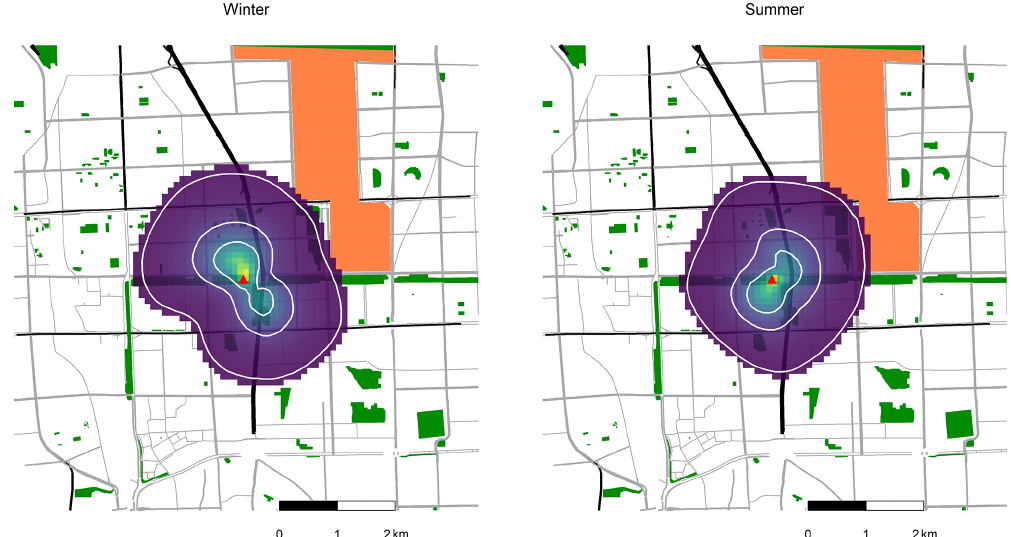
Figure 3. The mean flux footprints for the winter and summer campaigns. The site is shown by the red triangle in the centre of the map. Each square is 100m 2 and the brighter colours indicate a greater influence on measured emission for a particular area. The white rings show the areas contributing 30%, 60% and 90% to the flux total, with the inner ring representing the 30% contribution and the outer ring representing the 90% contribution. The 90% of the influence from the footprint extends up to 2km away from the tower with maximum contribution 0.26km away from the tower. Map was built using data from © OpenStreetMap contributors 2019. Distributed under a Creative Commons BY-SA License.